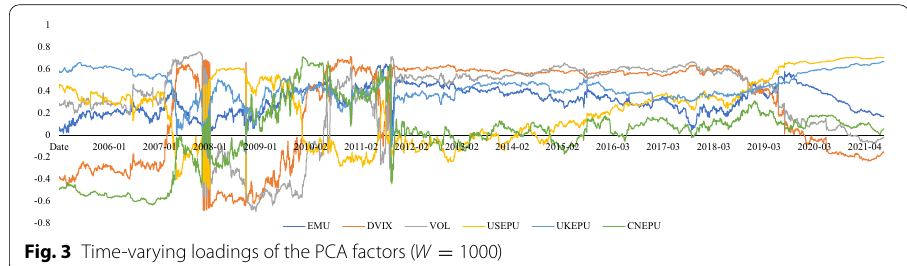
Fig. 3 Time-varying loadings of the PCA factors ( W = 1000 )